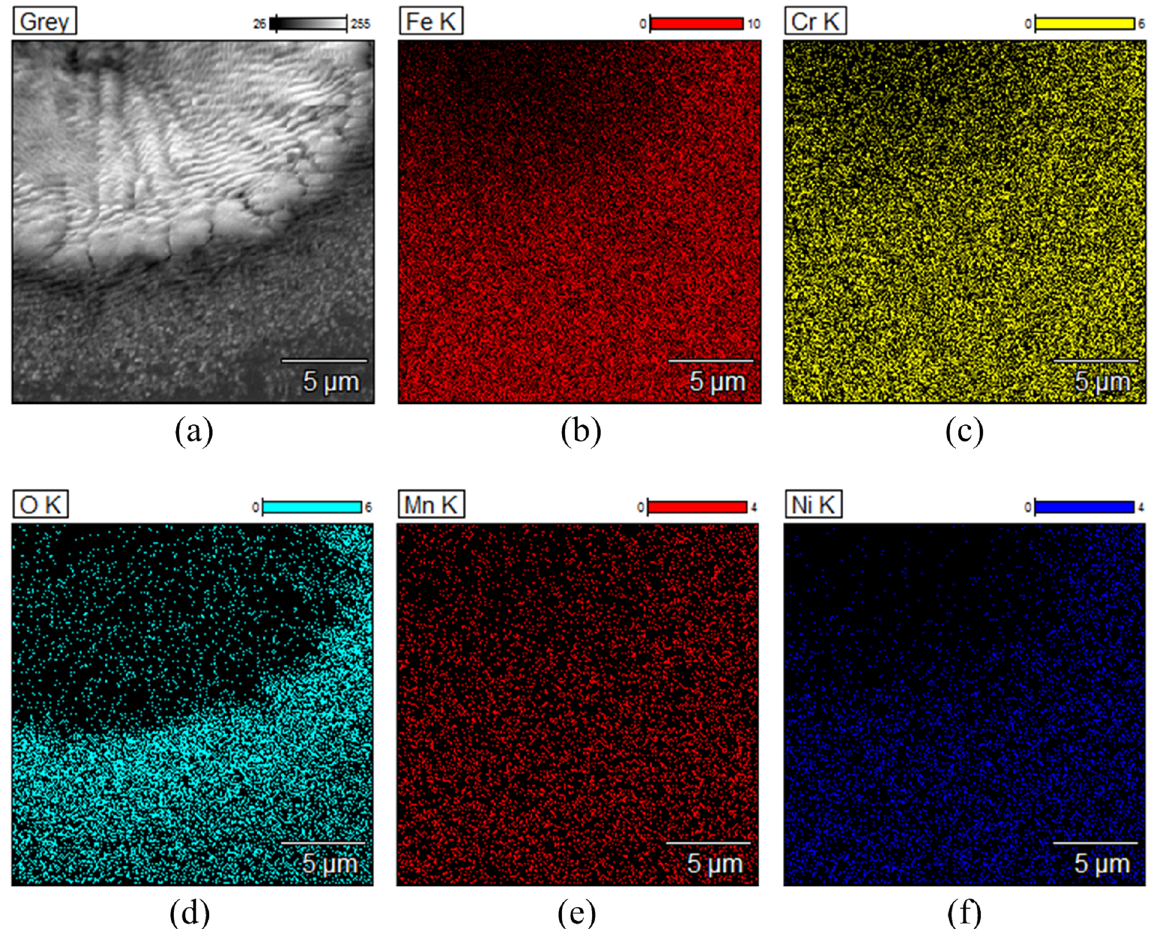
Figure 3. The SEM image and EDS image showing the distribution of